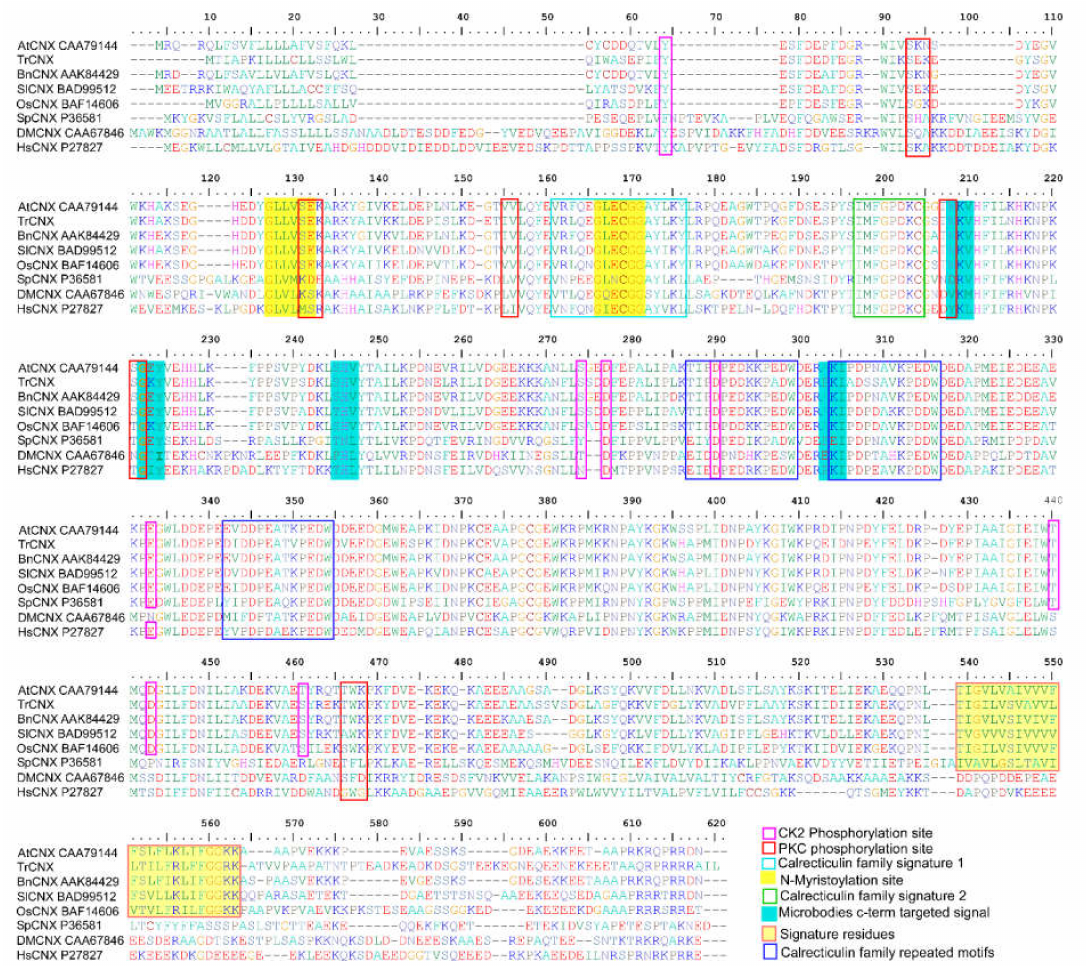
Figure 2. Comparison of deduced amino acid sequences of calnexin ( CNX ). Multiple sequence alignment of the TrCNX1 protein with various plant and non-plant CNX proteins. At, Arabidopsis thaliana (CAA79144); Tr, Tradescantia (KU530113); Br, Brassica napus (AAK84429); Sl, Solanum lycopersicum (BAD99512); Os, Oryza sativa (BAF14606); Sp, S accharomyces pombe (P36581); Dm, Drosophila melanogaster (AAF48618); Hs, Homo sapiens (P27824.2). Distinct structural features of putative conserved signature motifs and critical amino acid sites among CNX alignments are shown by di ff erent colored boxes (pink, red, blue, green, and deep blue) and are highlighted by shaded boxes (yellow and